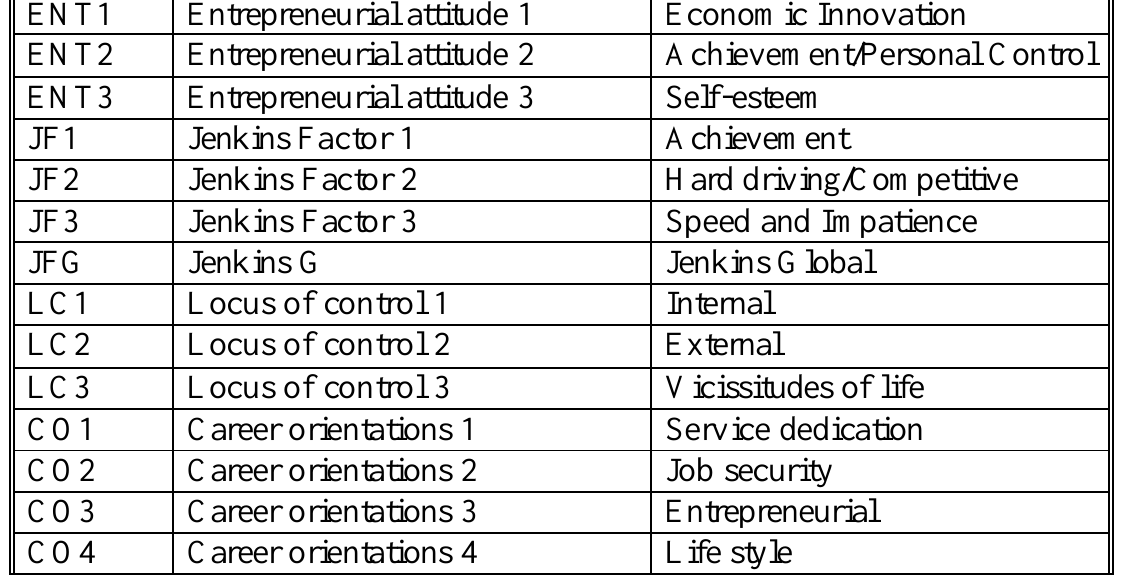
List of identified factors for each